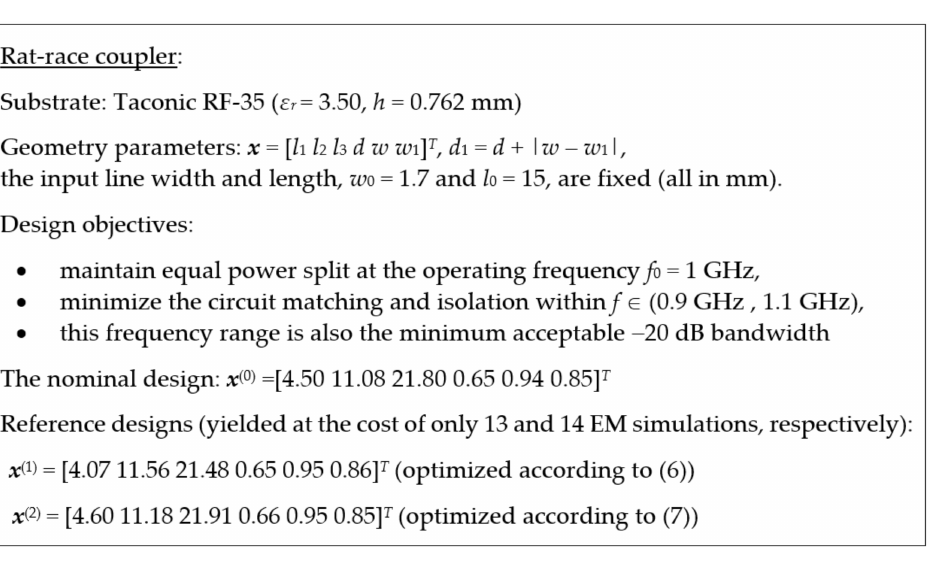
Figure 11. Description of the rat-race coupler of Figure 10 [68].